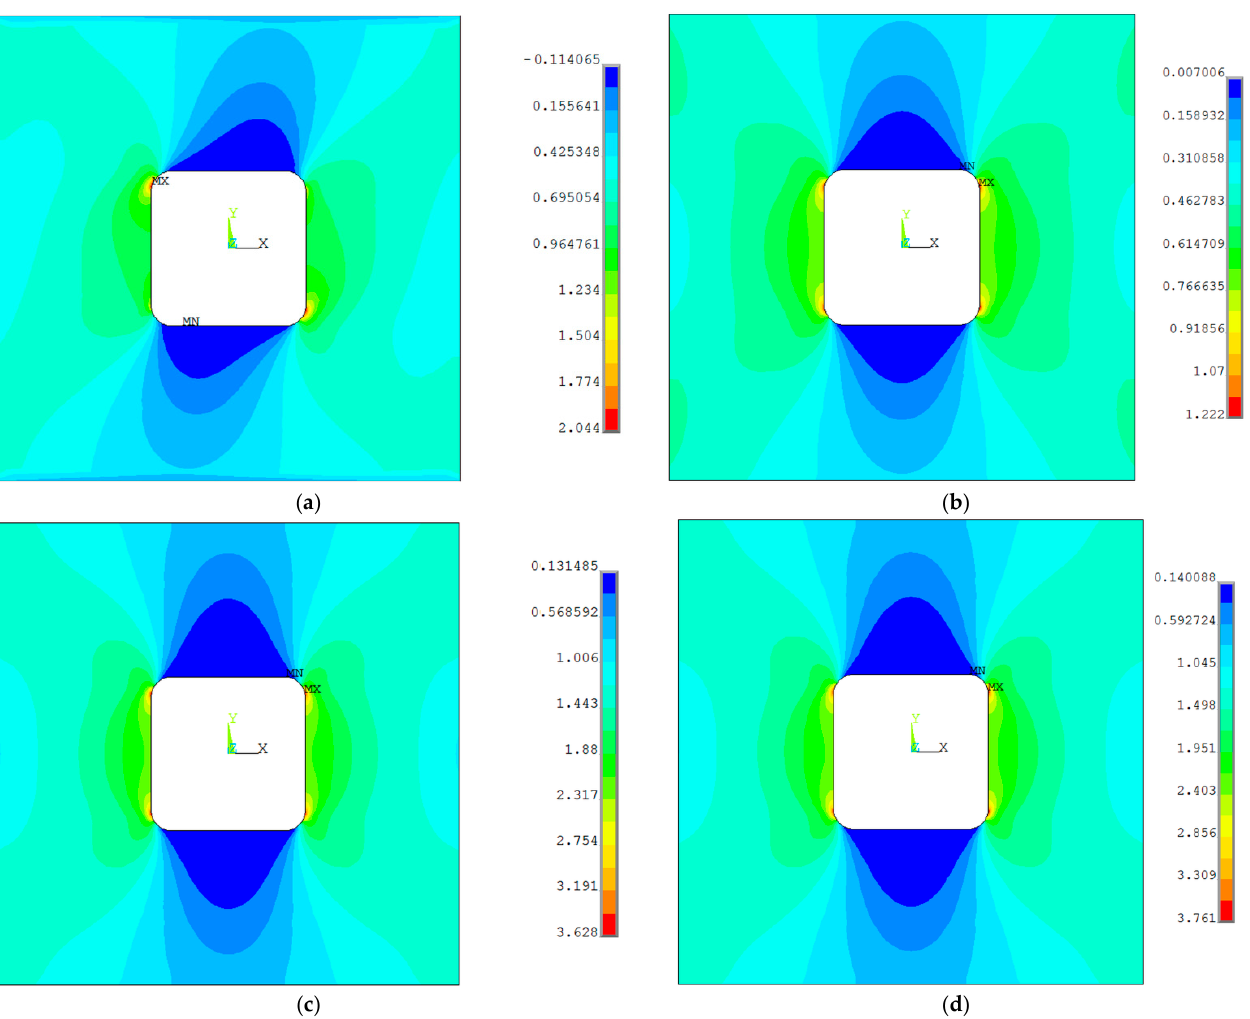
Figure 30. Distribution of tension stress σ ycomp for top composite layer for square patch (45 × 45), for different fiber angle orientation: ( a ) θ = ±45°;( b ) θ = 90°;( c ) θ = 0°;( d ) θ = 0°/90°.